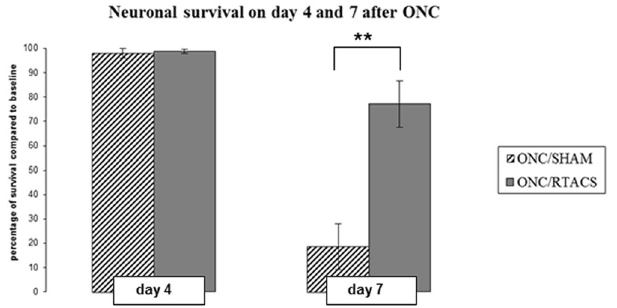
Figure 2. Neuronal survival on day 4 and 7 post ONC with and without stimulation. This bar graph demonstrates the significant effect of rtACS on neuronal survival on day 7 post ONC. Whereas on day 4 post ONC almost no reduction in cell number was detected in both groups (ONC/SHAM and ONC/rtACS) and no statistical difference between the groups was detected, on day 7 post ONC a significantly higher percentage of surviving neurons was observed in the ONC/rtACS compared to the ONC/SHAM